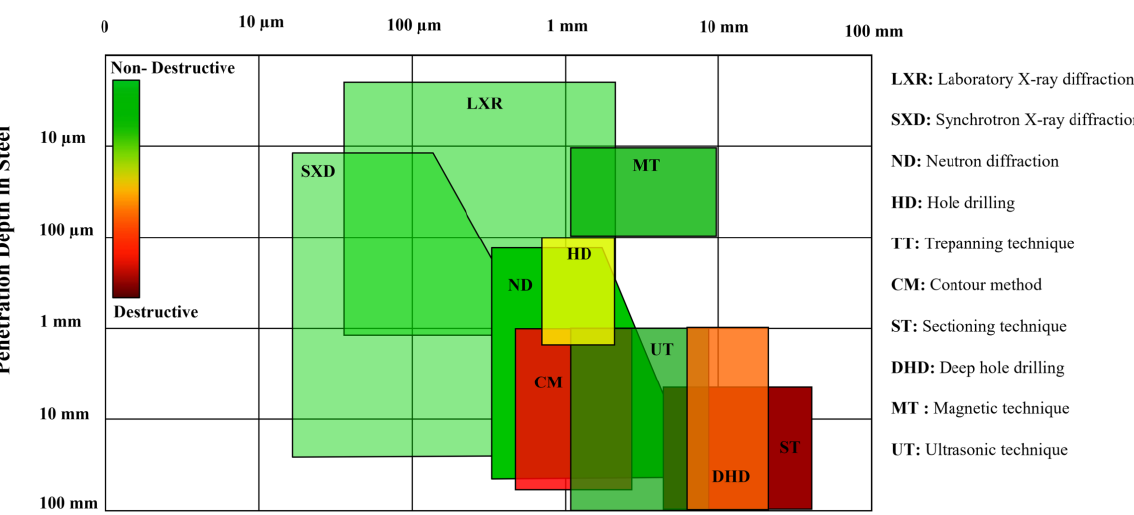
Figure 3. Spatial resolution and penetration depth of destructive and non-destructive residual stress measurement techniques for